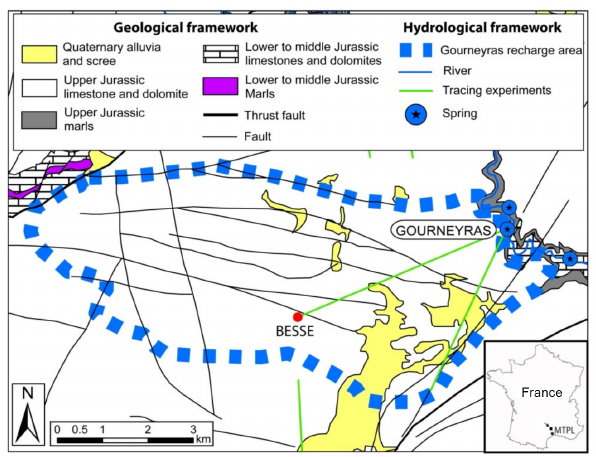
Figure 3. Hydrogeological location map of Gourneyras karst sys- tem. Besses cave is indicated by a red dot